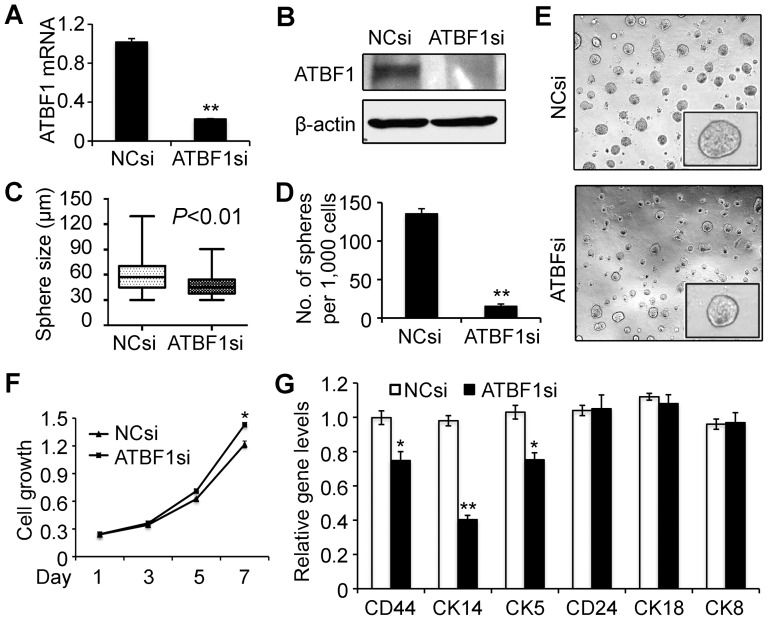
Knockdown of ATBF1 interrupts mammosphere formation and reduces the expression of basal cell markers.(A, B) Cells transfected with negative control siRNA (NCsi) or ATBF1 siRNA (ATBF1si) were subjected to real time RT-PCR for mRNA expression (A) and western blotting for protein expression (B). (C) Distribution of diameters of all mammospheres at 2-weeks of culture in Matrigel. The average sphere size for ATBF1 knockdown is significantly smaller than that for the control. (D) Knockdown of ATBF1 significantly reduces the number of spheres with a diameter >75 µm. The data are presented as the number of defined mammospheres per 1,000 seeded cells ± SEM. (E) Representative bright field images for spheres from both groups. (F) Measurement of cell numbers for MCF10A cells treated with NCsi or ATBF1si in 24-well plates (2-D culture). (G) Expression of both basal cell markers (CD44, CK14 and CK5) and luminal cell markers (CD24, CK18 and CK8) in MCF10A cells in Matrigel, as detected by real time RT-PCR. * and ** indicate P<0.05 and P<0.01 respectively (student's t test).